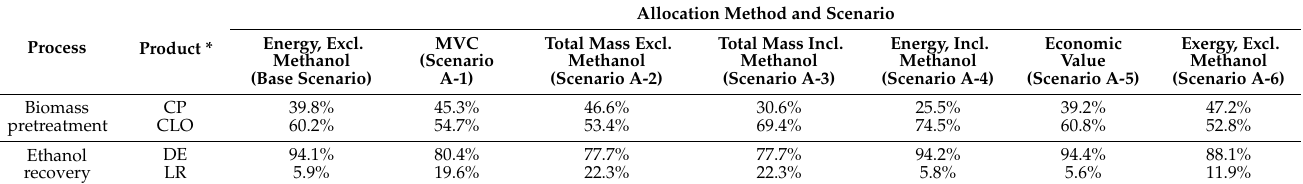
Table A3. Allocation factors.